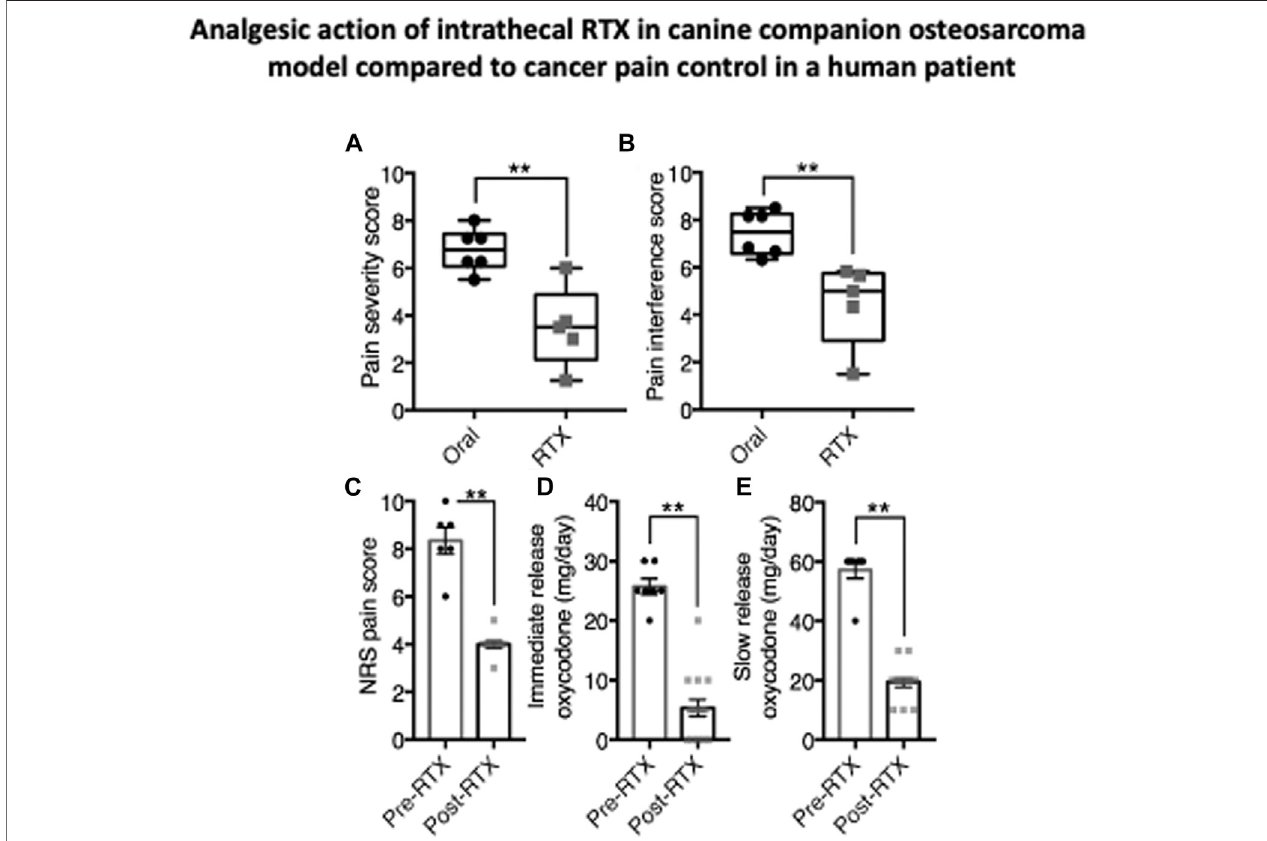
FIGURE 3 | Analgesic action of intrathecal RTX in companion canine osteosarcoma model. compared to cancer pain control in a human patient. Dogs with appendicular osteosarcoma ( n (cid:1) 6), and a human patient with intractable cancer pain ( n (cid:1) 1) were injected intrathecally with RTX (1.2 μ g/kg and 13 μ g, respectively). SubsequenttoITRTXtreatment,dogswerereleasedtotheirownersandpainassessmentsweremadeatmonthlyintervals.Ownersforeachdogratedpainseverityand interference with function using the Canine Brief Pain Inventory (79). Pain Severity (A) and Pain Interference (B) scores for companion dogs treated with RTX were signi fi cantly decreased relative to dogs kept on traditional standard of care oral pain medications alone. Data from the one human patient were collected over 7 days before RTX and 15 days after RTX injection while an in-patient on the oncology ward. Beginning immediately after RTX treatment, NRS pain scores (0 – 10) decreased from about eight to about 4 (C) Concurrently, self-administration of immediate release oxycodone was decreased (D) as was slow-release oxycodone during the same period (E) Statistical comparisons were made using two-tailed Mann-Whitney U test (**, p < 0.01) (data from Sapio et al., 2018, with permission). The analgesic effect in thehumanisremarkablysimilartothatseenintreateddogsin Figure2 andreductionsincanineanalgesicdrugtreatmentsarealsoobserved(Brownetal.,2005;Brown D. C. et al.,